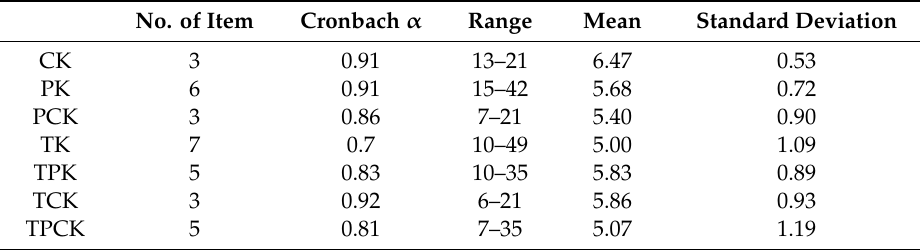
Table 3. Summary of description results of